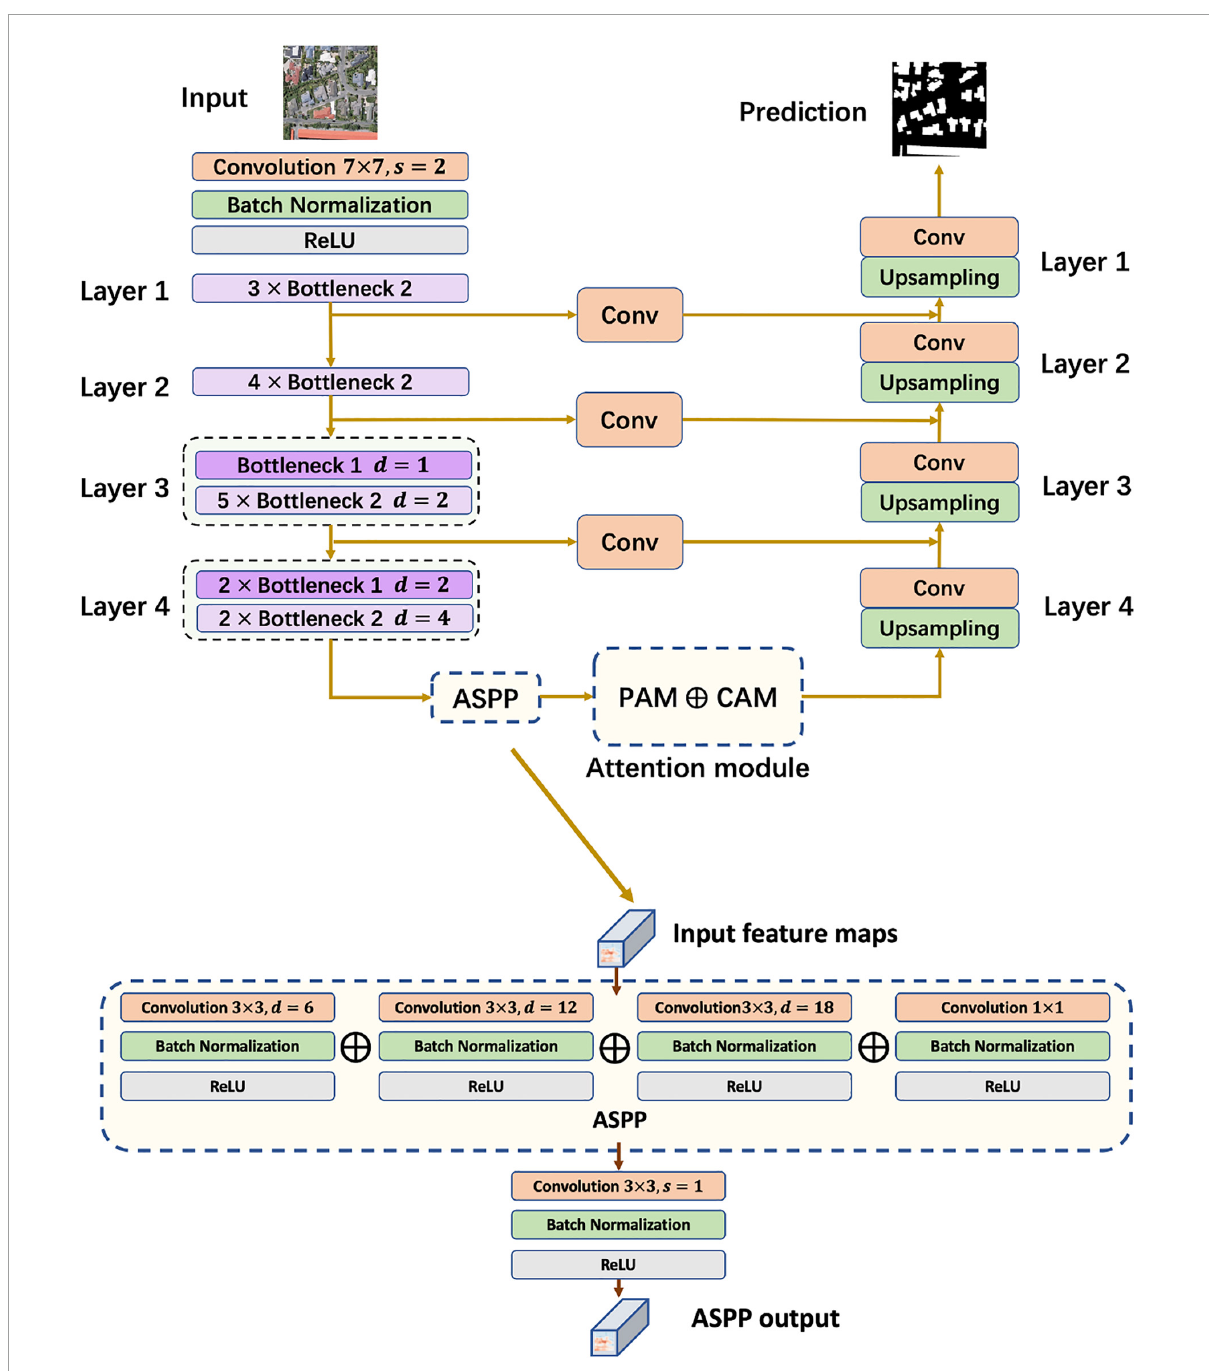
FIGURE4 Framework of segmentation model and atrous spatial pyramid pooling.